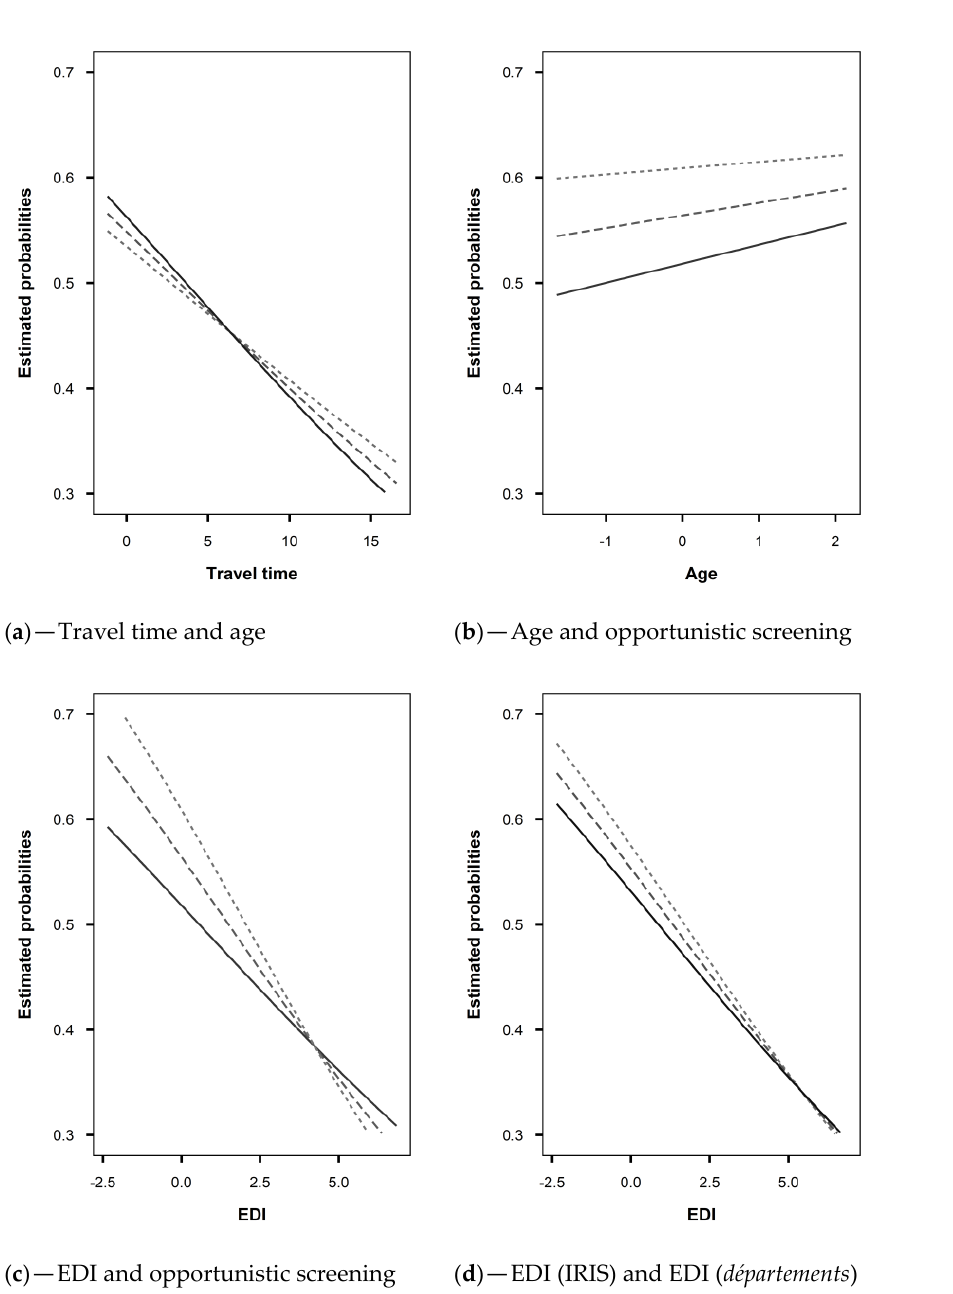
Figure 4. Interactions in the final model. ( a ) Travel time and age, ( b ) Age and opportunistic screening, ( c ) EDI and opportunistic screening, ( d ) EDI (IRIS) and EDI ( départements )